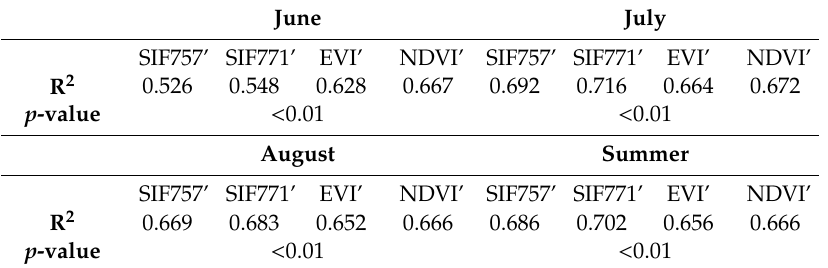
Table 1. The correlations between the SIF757’, SIF771’, EVI’, NDVI’, and the government’s autumn crop production statistics in China during June to August 2015 at monthly and seasonal scales.